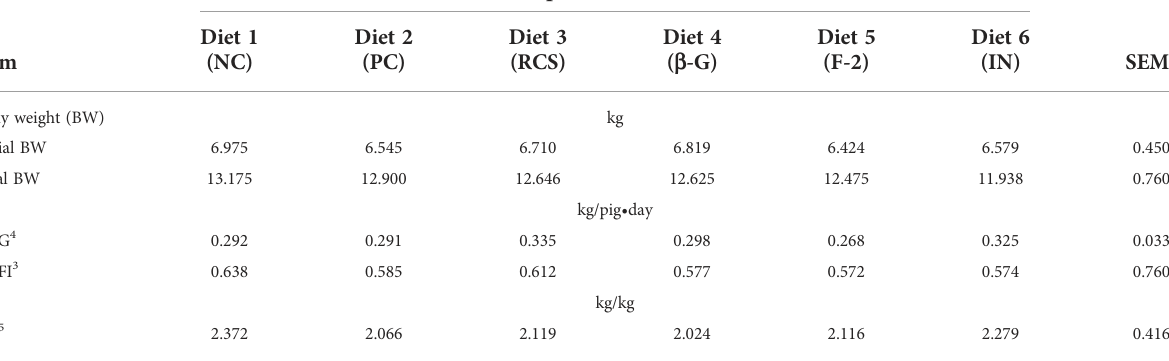
TABLE 2 The effects of dietary supplementation of three prebiotics and b -glucan on growth performances in the pigs weaned at 3 weeks (wk) of age and fed the corn and soybean meal-based diets for 3